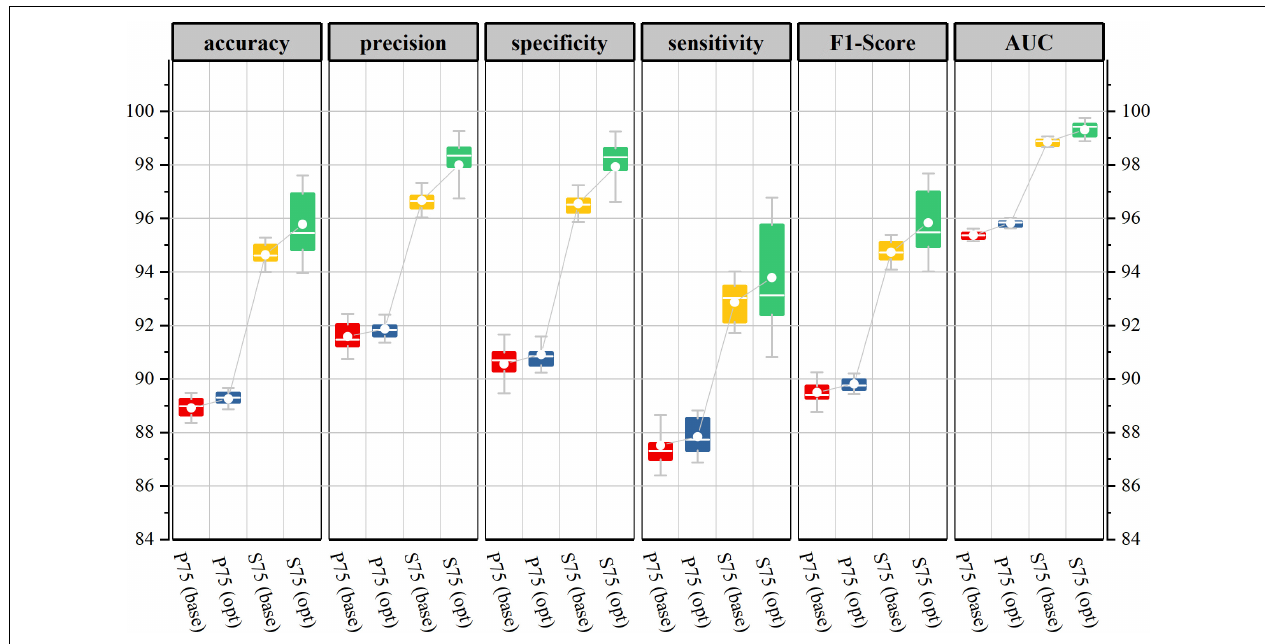
FIGURE 10 | Test performance of two network structures on data sets P75, S75.